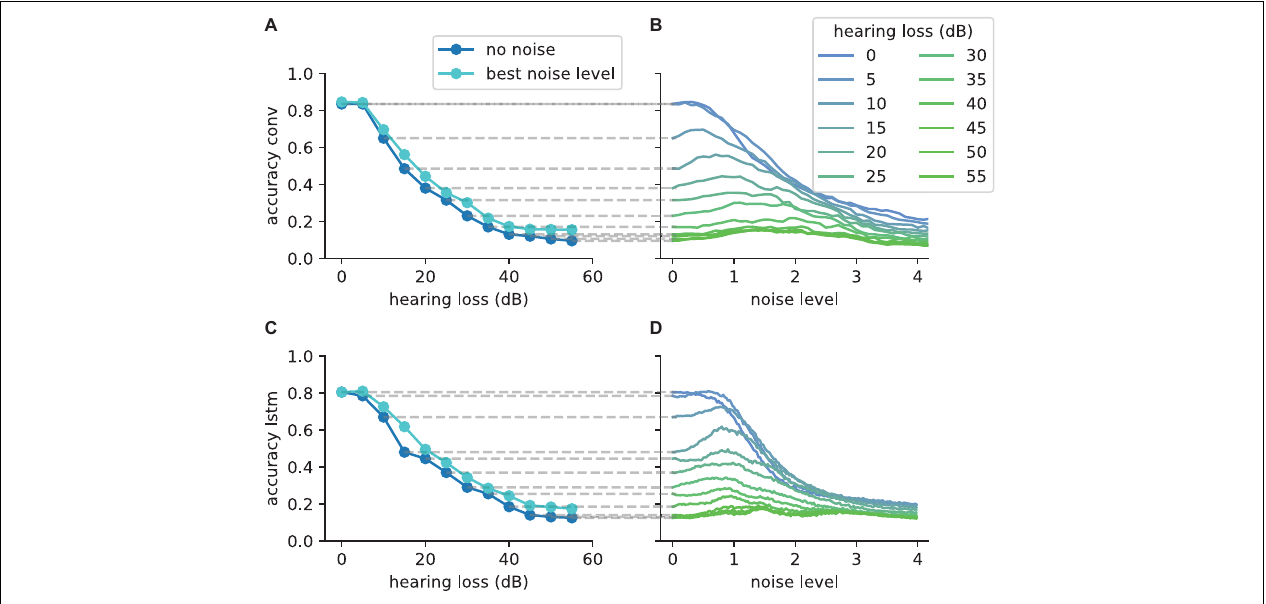
FIGURE 10 | The SR resonance effect in different network architectures using the FSDD data set. (A) The plot shows the test accuracy as a function of the applied hearing loss for a deep convolutional network architecture (dark blue, starting at 400 Hz, exact network architecture shown in Table 2 ) trained on English words (digits: 0–9). The impaired speech comprehension by the hearing loss can be partly compensated by adding Gaussian noise (stochastic resonance). The cyan curve shows the improvement of speech comprehension for the optimal noise level (maxima values in panel B ). (B) Test accuracy for different hearing losses (shades of blue) as a function of the added noise. The maxima show that SR can help to restore speech comprehension. (C) Similar analysis as shown in panel (A) for a two layer LSTM network (exact network architecture shown in Table 3 ); (D) Similar analysis as shown in panel (B) for the LSTM architecture. The improvement of speech perception in impaired systems (hearing loss) is a universal principle and does not depend on the used neural